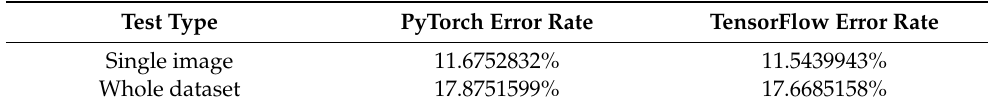
Table 2. Error rate for PyTorch and TensorFlow [19].